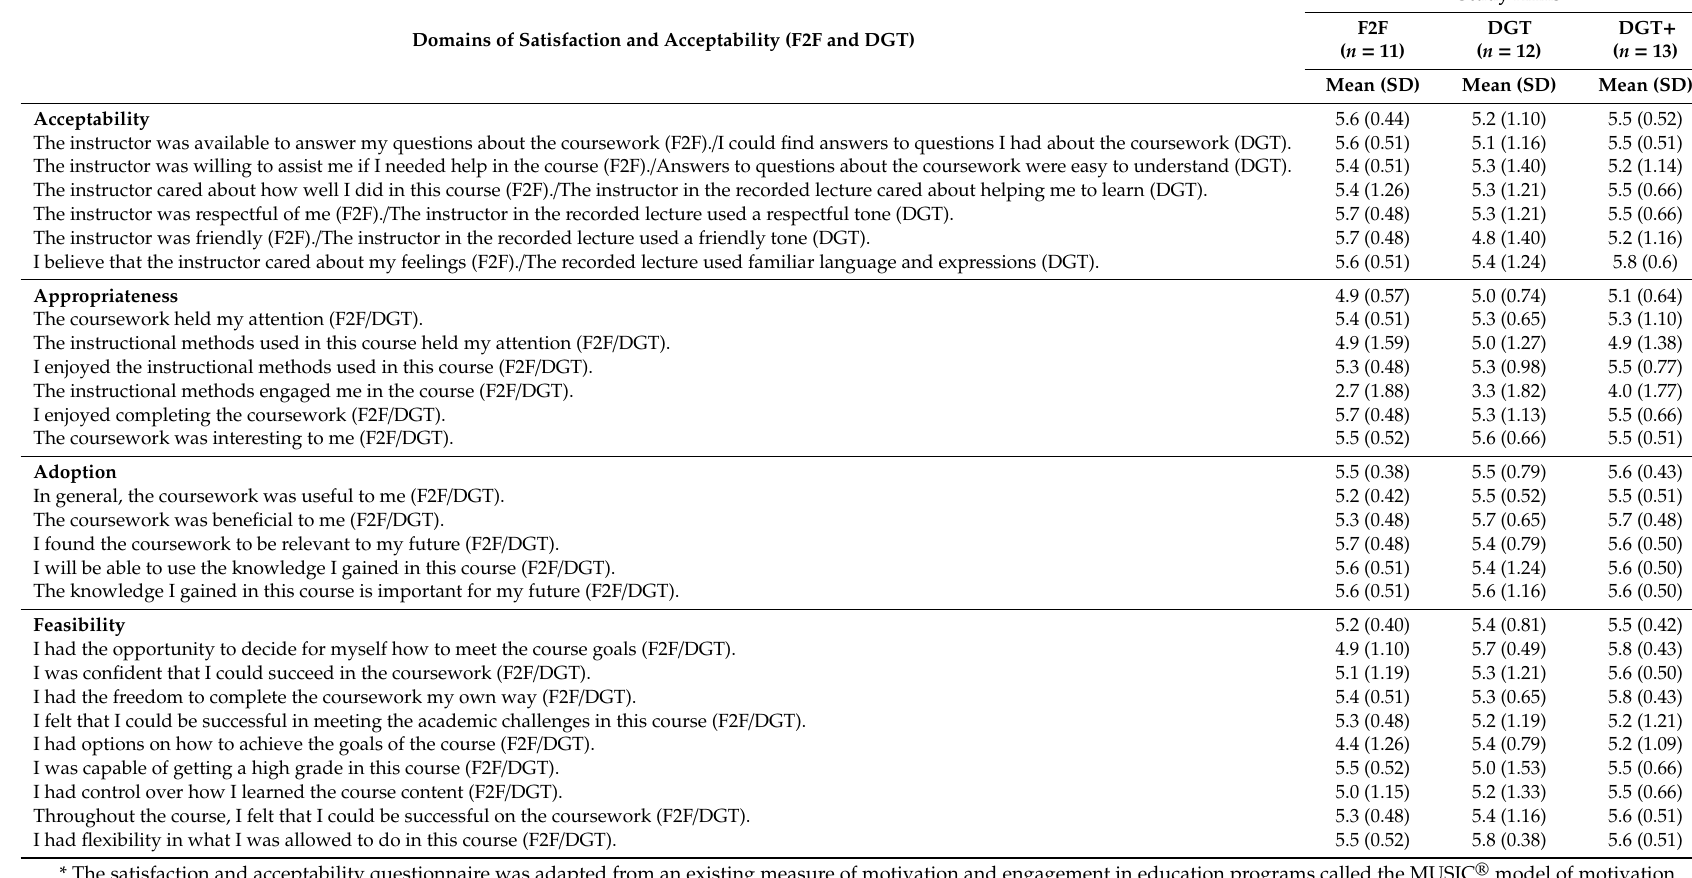
Table 4. Participant ratings of satisfaction and acceptability with the training programs